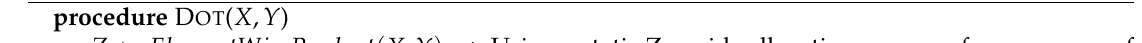
Algorithm 4 Optimized dot